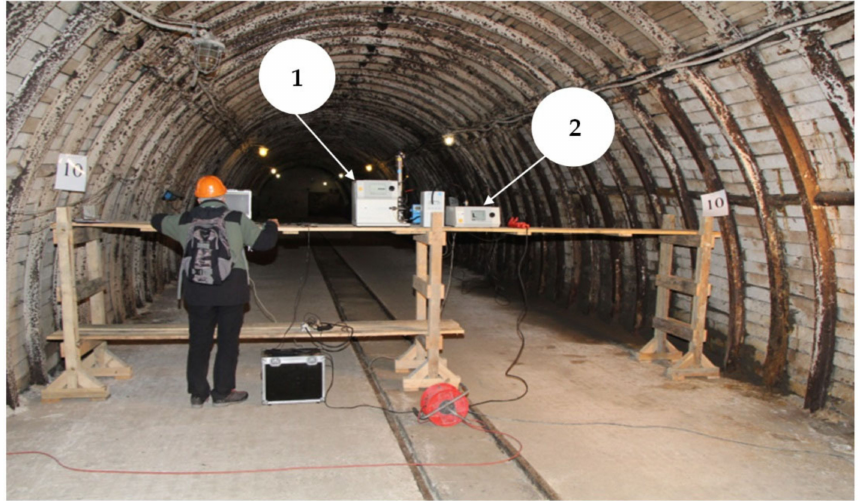
Figure 3. View of laboratory rig in the underground experimental excavation: 1—Spectrometer SMPS 3936; 2—Spectrometer APS